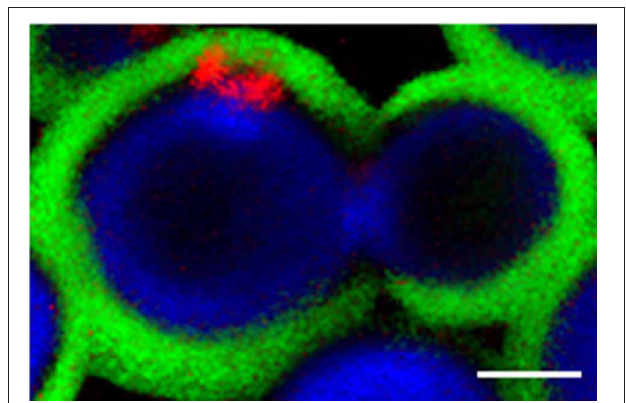
FIGURE 1 | Confocal section of budding C. neoformans cells. Cell wall chitin (blue fluorescence), capsular GXM (green fluorescence) and chitin oligosaccharides at the cell wall-capsule interface (red fluorescence) were stained as described in Rodrigues et al. (2008a). The image demonstrates that chitin oligosaccharides interact with GXM. Scale bar, 1 μ